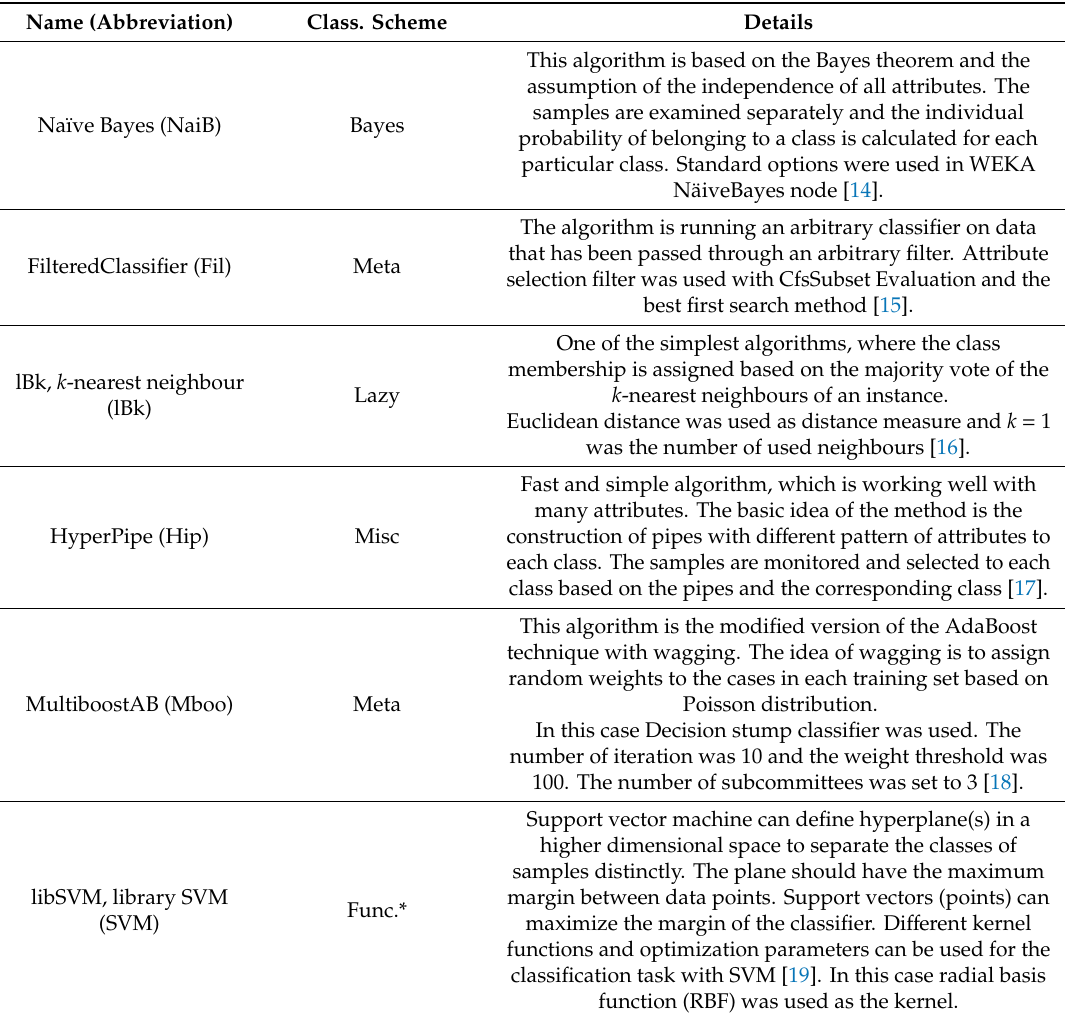
Table 2. Summary of the machine learning algorithms. Abbreviations are the names found in the WEKA package. Classification schemes are more general categories (types) of the algorithms. (* Func. is short for